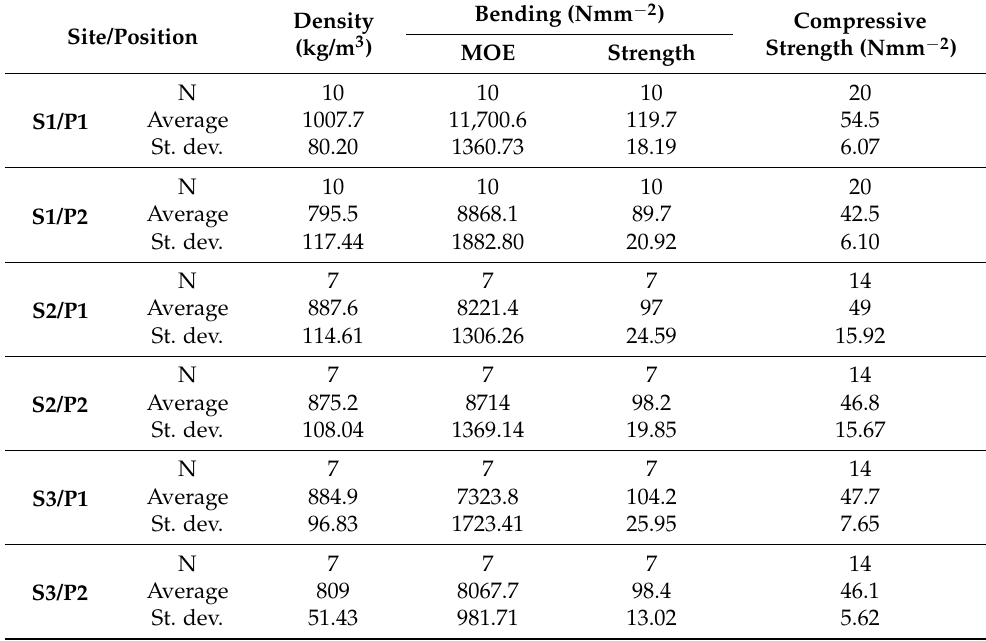
Table 1. Density, MOE bending and compressive and bending strength for the tree sites and two distances to the pith considered.